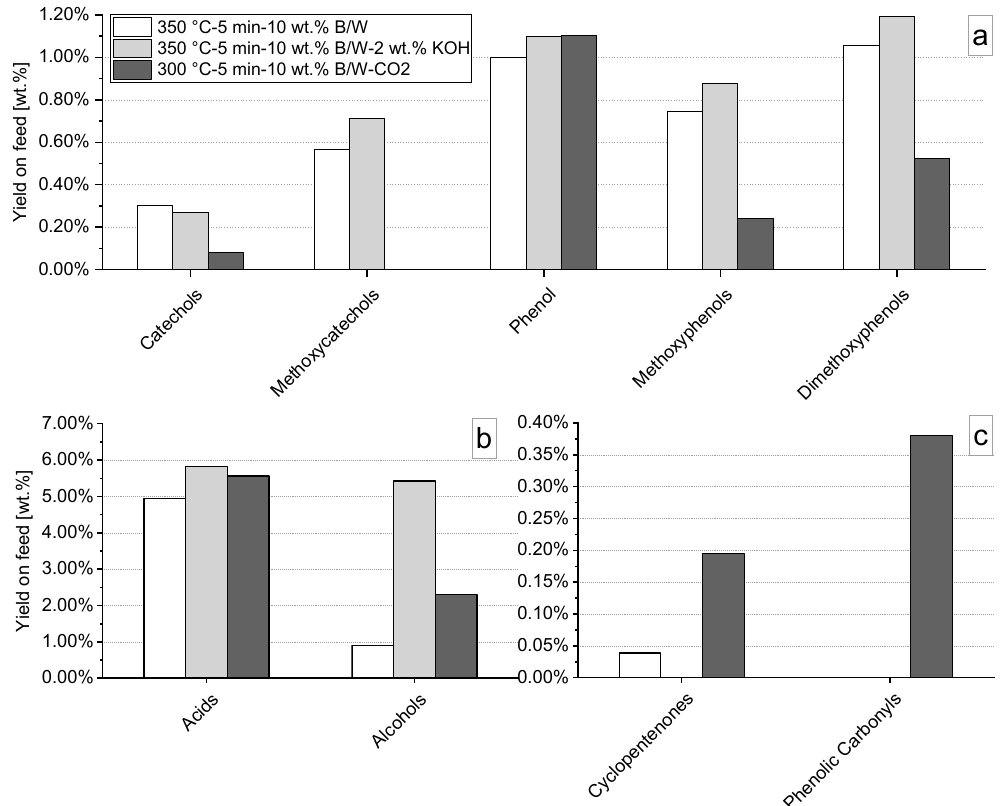
Figure 10. E ff ect of CO 2 acid catalyzed reaction compared to base catalyzed and blank tests on yields of quantified compounds: ( a ) phenolics, ( b ) acids and alcohols, ( c ) phenolic carbonyls, and cyclopentenones. When no graph column is depicted, the concentration was below quantification limits.